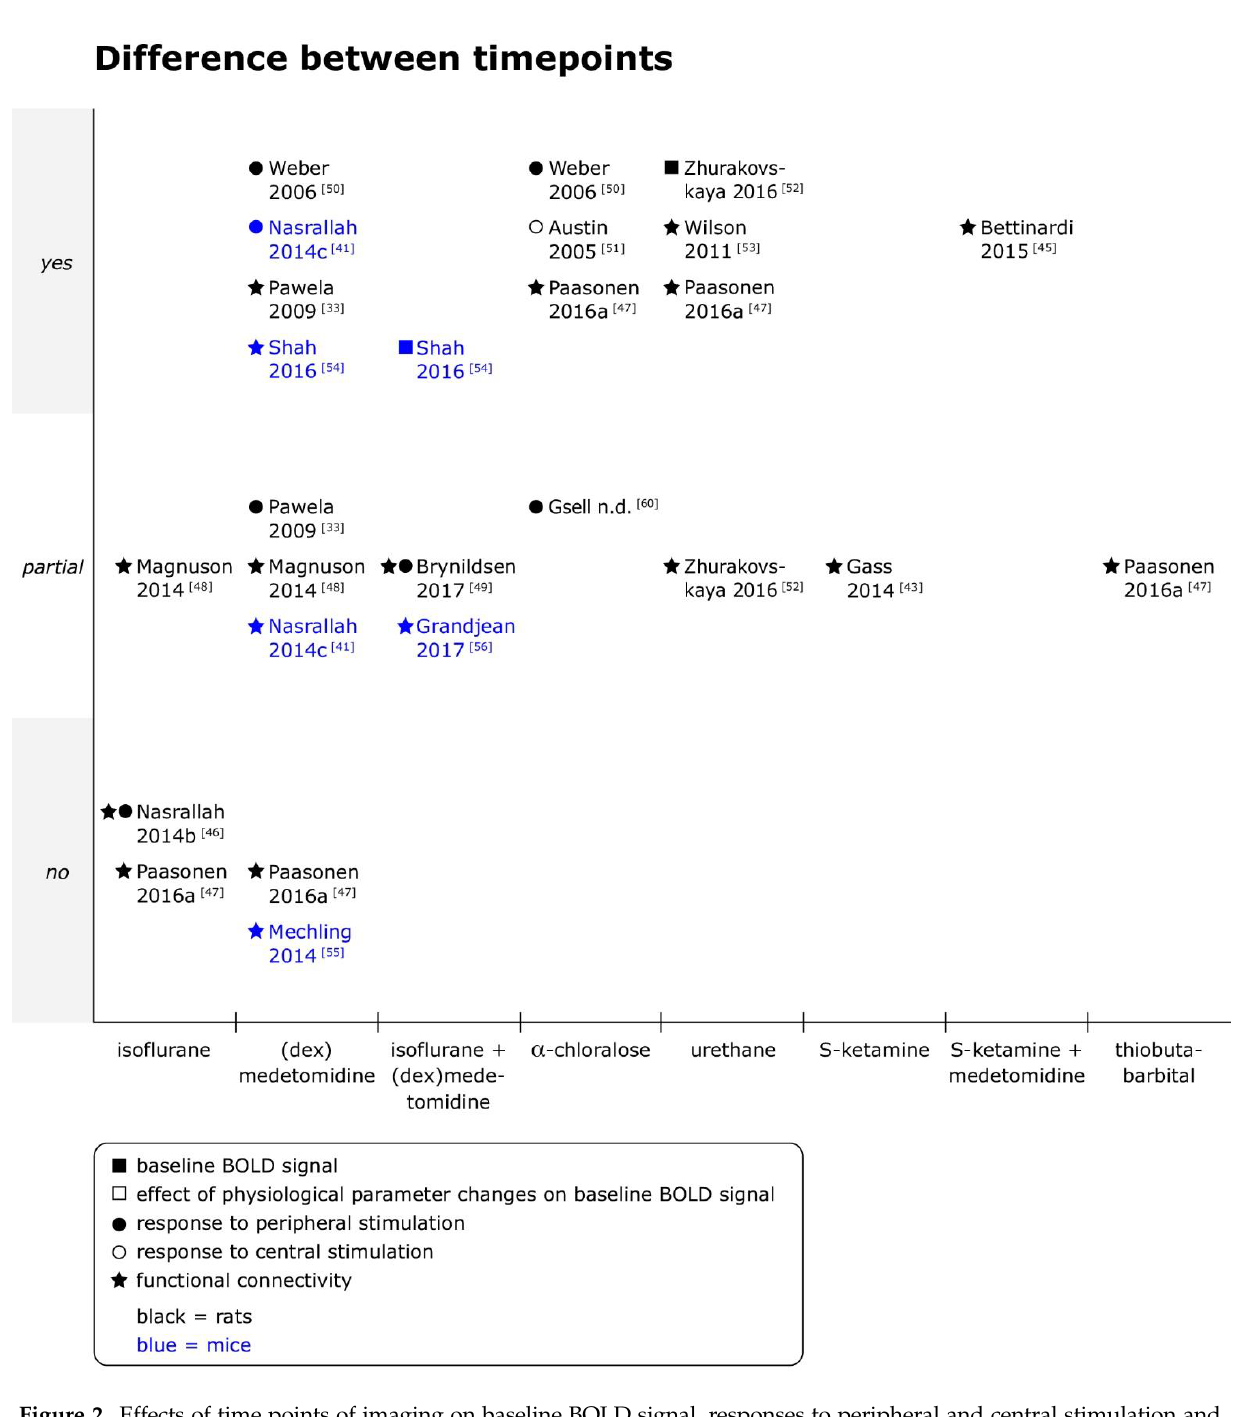
Figure 2. Effects of time points of imaging on baseline BOLD signal, responses to peripheral and central stimulation and functional connectivity in rats and mice. Yes = differences between timepoints were clearly observed; partial = differences between timepoints were observed for some outcomes, analyses or animals, but not consistently, or quantitative differences were reported, but statistical significance unclear; and no = no differences between timepoints were observed. When datasets were re-analyzed, findings were pooled and one data point per specific comparison (i.e., per anesthetic per type of fMRI) displayed. (dex)medetomidine = medetomidine or dexmedetomidine was studied. Not all references are discussed in the text [43,45], but a summary of the main findings as well as the doses of anesthetics are provided for references with the symbols (cid:4) or (cid:3) in Supplementary Materials Tables S2 and S5, with symbols • or in Supplementary Materials Table S3 and S5, and for (cid:35) references with symbol (cid:70) in Supplementary Materials Tables S4 and